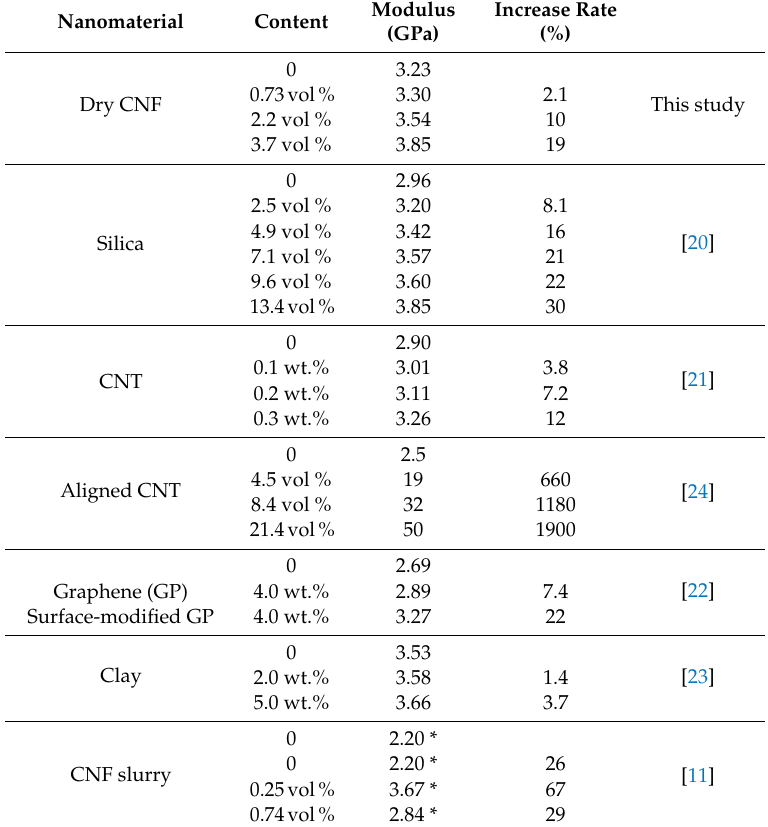
Table 1. Comparison of the Young’s modulus of epoxy matrix nanocomposites.